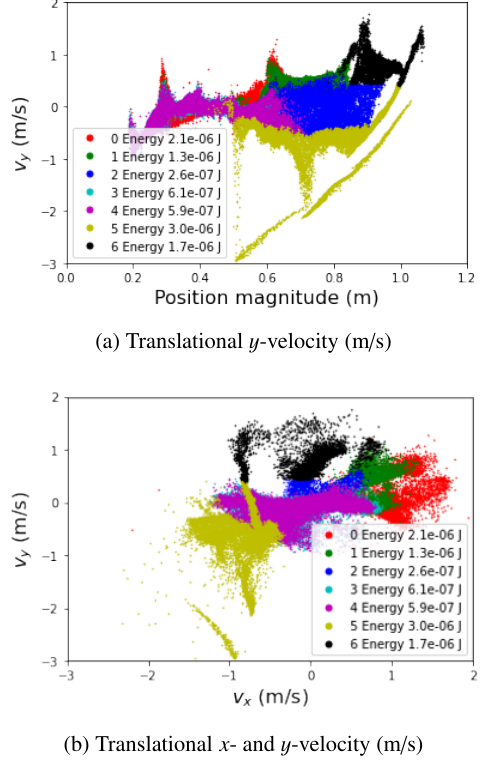
Figure 6: Non-conventional spatial visualisation of standard or corroborative information. Total kinetic energy for each spatial domain is